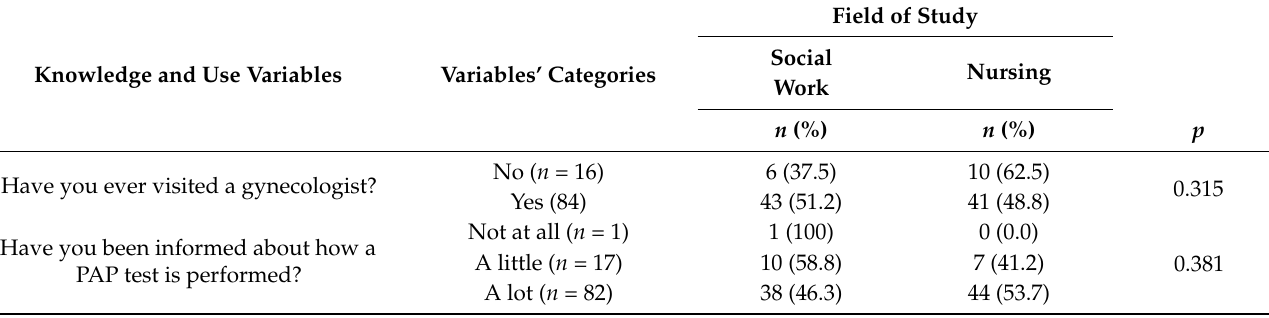
Table 2. Knowledge about cervical cancer and use of gynecological cancer